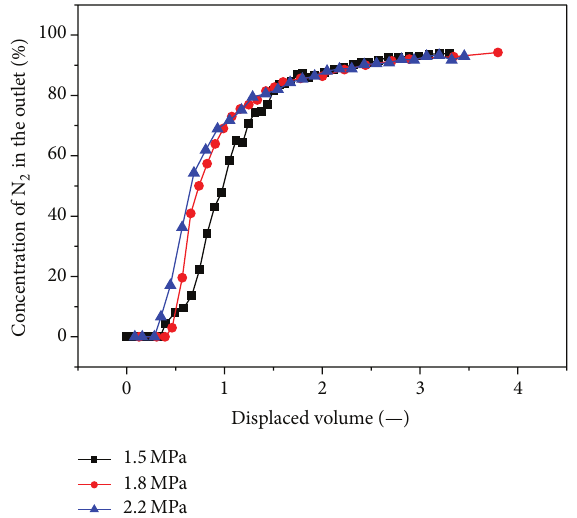
Figure 13: Influence on the output CO 2 concentration by different gas injection pressures.